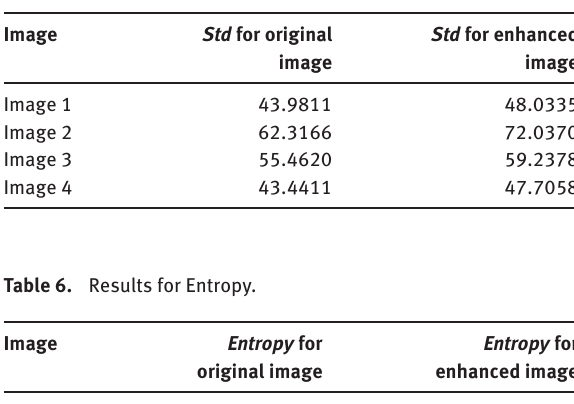
Table 5. Results for Standard Deviation ( Std ).